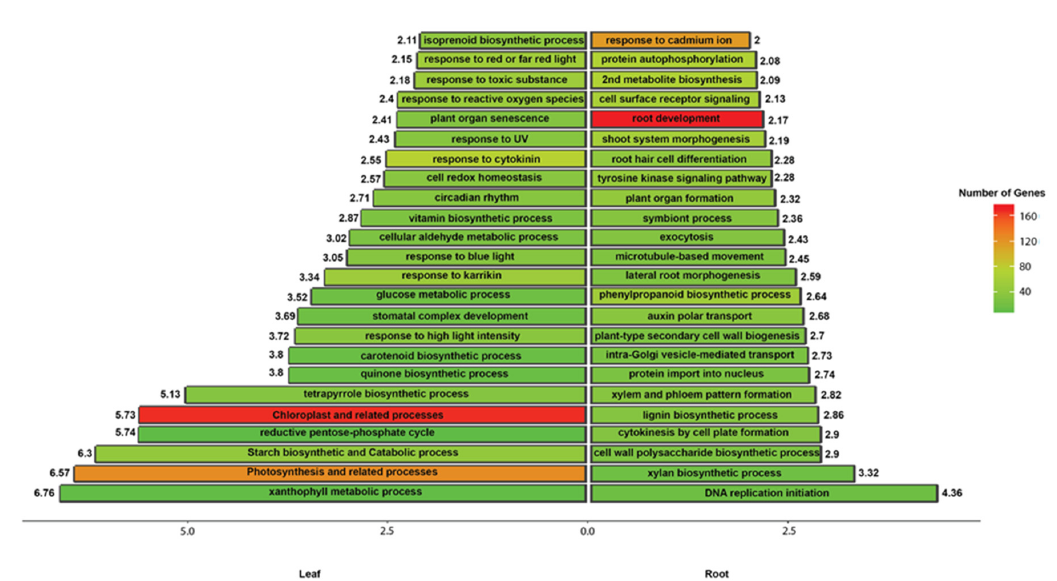
Figure 3. Gene Ontology (GO) enrichment analysis of the differentially expressed contigs (DECs) identified in leaf and root tissues. The left bars and the right bars show the GO terms enriched within the Biological Process ontologies in the leaf and root, respectively. The x-axis shows the fold change of each GO term, which is also provided as a number next to each bar (GO term). The colors represent the number of contigs represented within each GO term (bar).